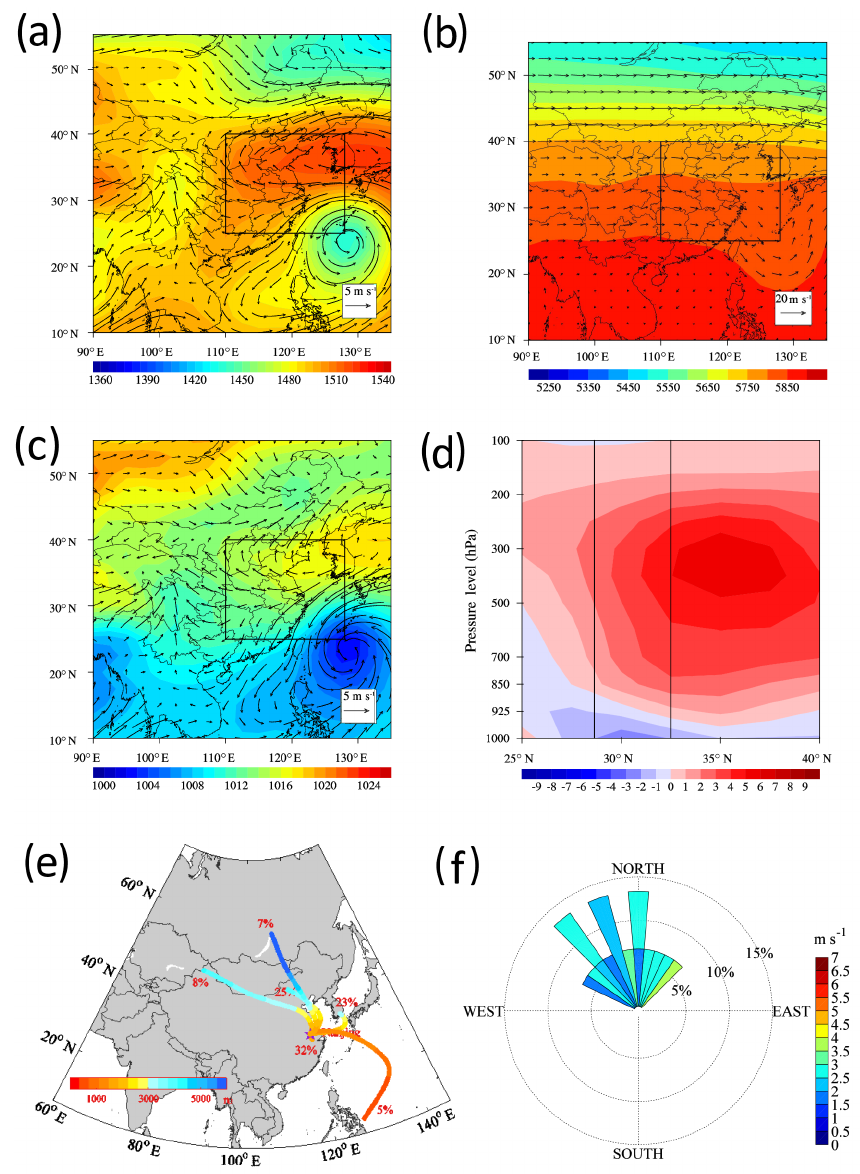
Figure 10. As in Fig. 7, but for Pattern